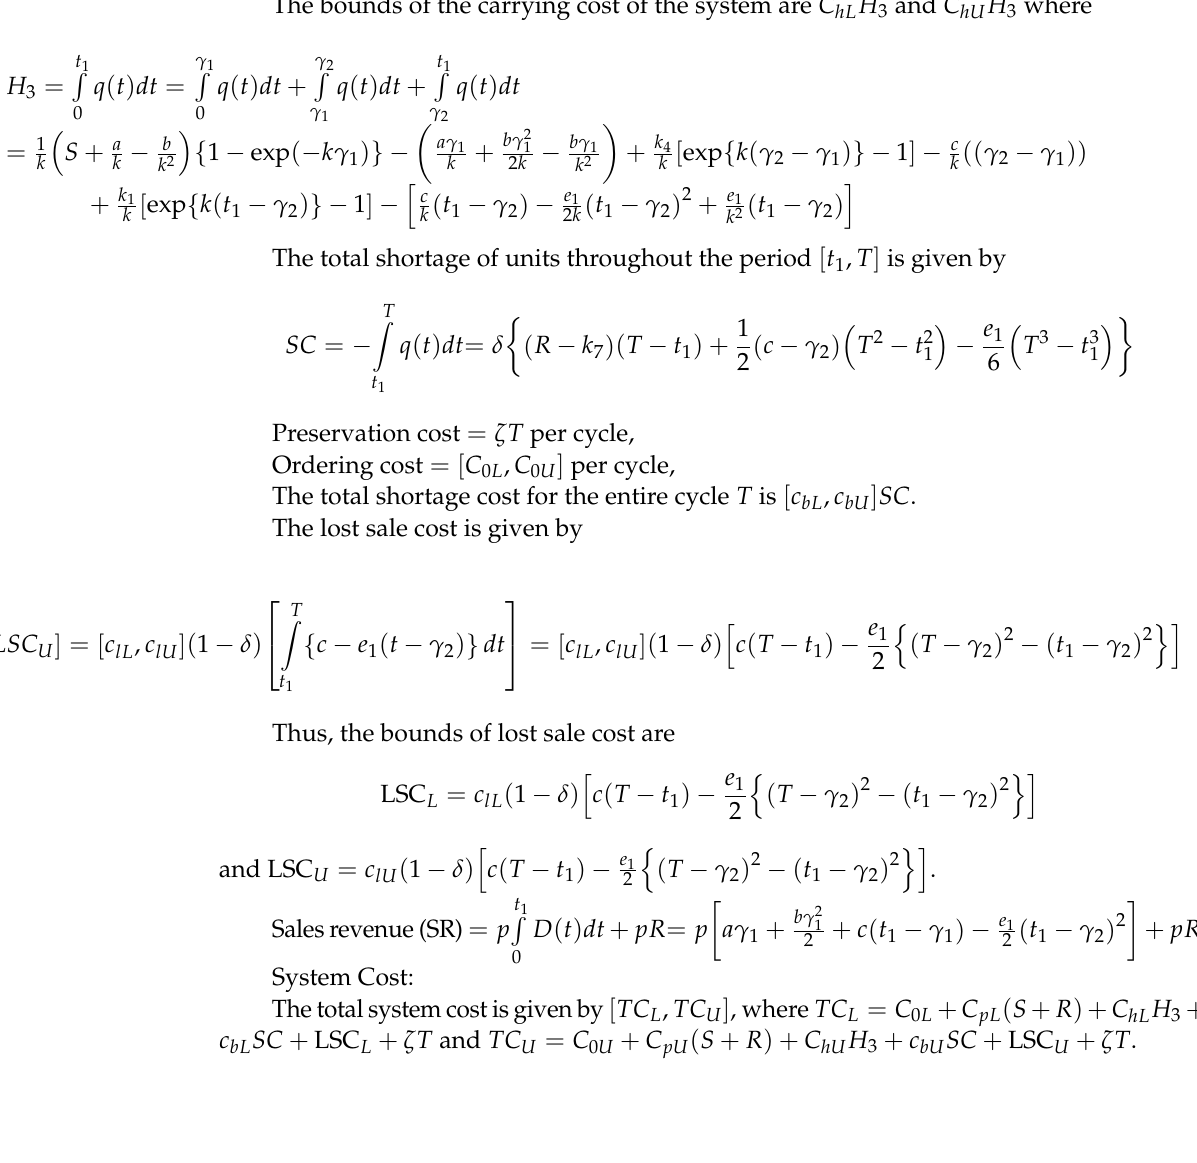
(cid:3) (cid:2) D (cid:48) . p (cid:48) , p (cid:48) U L